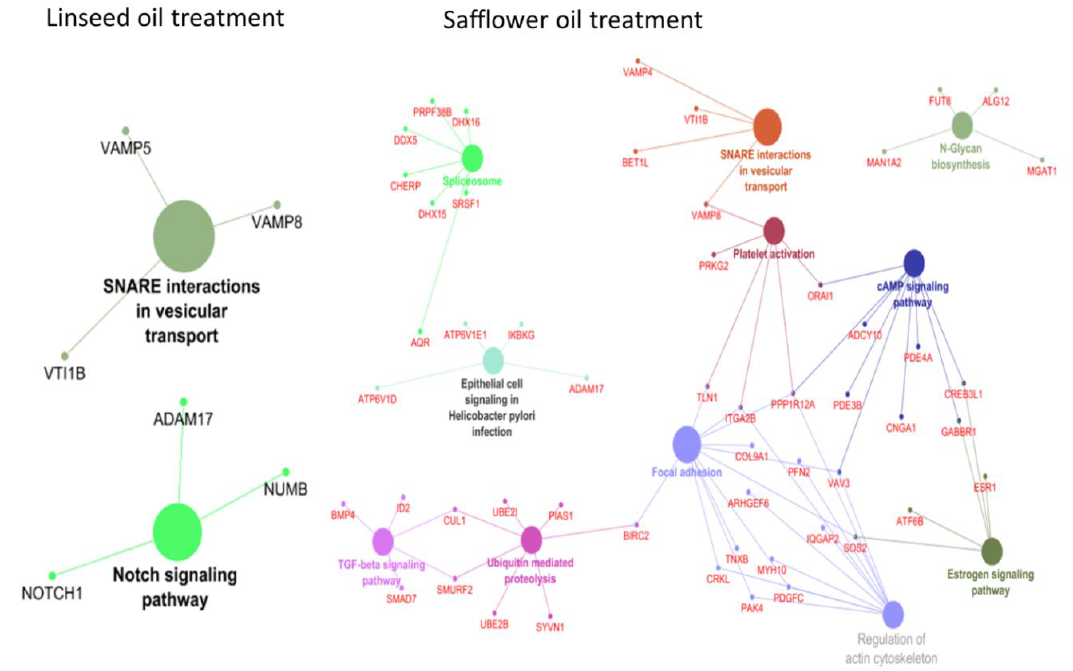
Figure 3. Enriched KEGG pathways for predicted cis target genes of